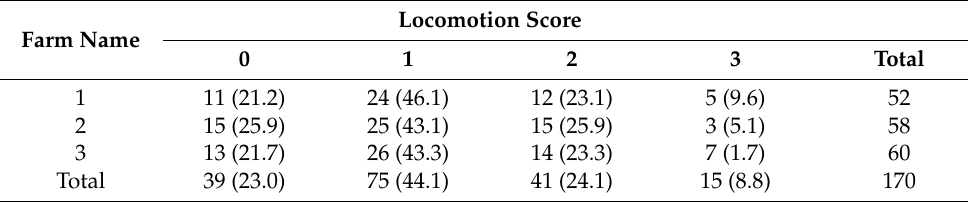
Table 2. Distribution of locomotion score and their percentage in brackets on three farms in Morogoro, Tanzania ( n = 170).